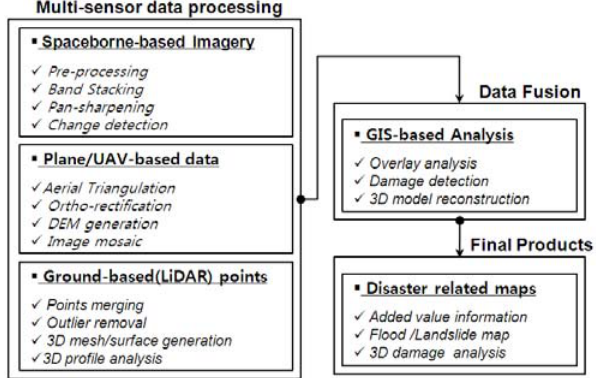
Figure 1. Flowchart of multi-sensor data